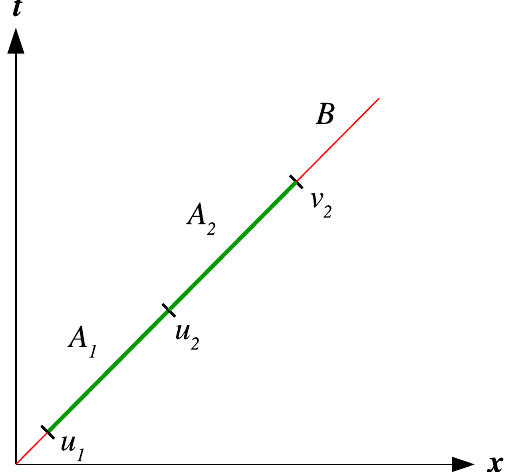
Fig. 3 Two adjacent intervals in a GCFT 1 + 1